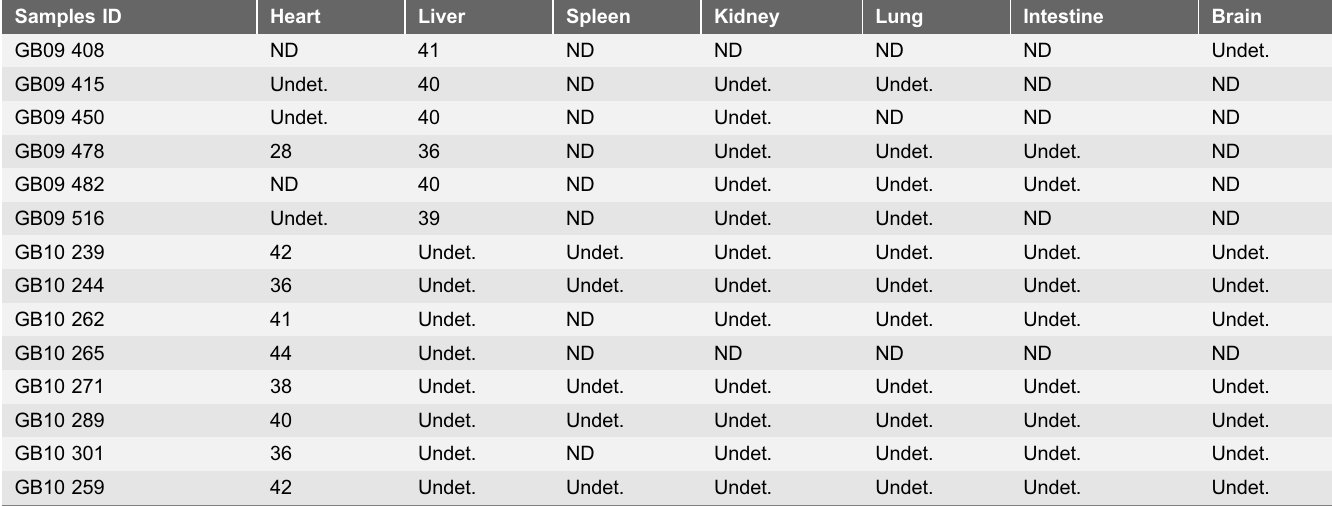
Table 2. Results of real-time PCR on organs from Coleura afra individuals. Samples ID Heart Spleen Intestine Brain